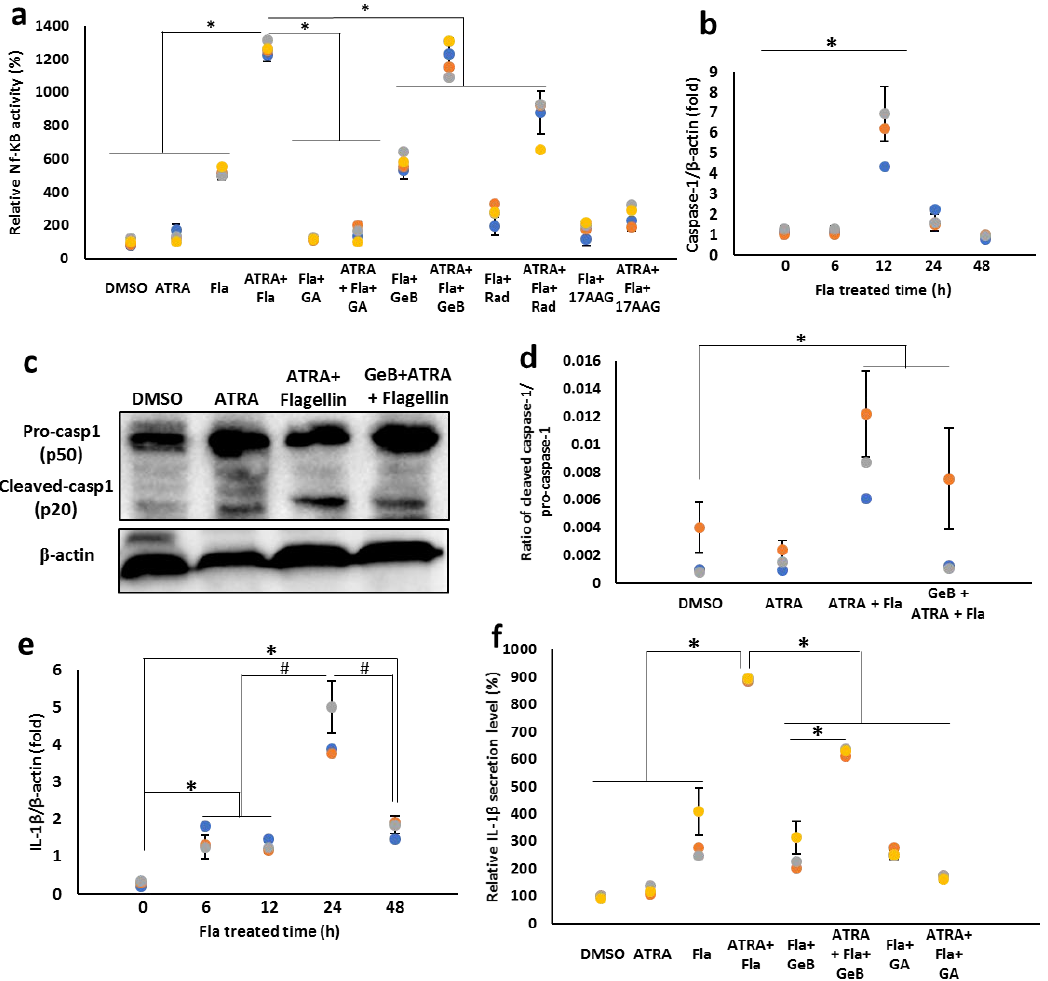
Figure 9. Exogenously administered flagellin activates caspase-1 and induces IL-1 β secretion in an Hsp90-dependent manner. ( a ) NF- κ B activity. THP-1 Xblue cells were stimulated with 1 µ M ATRA in the presence or absence of different Hsp90 inhibitors, followed by 48 h treatment with 100 ng/mL flagellin. After stimulation, a 20 µ L aliquot of the supernatant was collected and added to 180 µ L of Quanti-Blue medium for color development at 37 ◦ C. After 2 h color development, absorbance measurements were performed using an ELISA plate reader at 630 nm. Bar graphs indicate the optical density. ( b , c ) Caspase-1 mRNA and protein expression. To measure mRNA expression, THP-1 cells were treated with 1 µ M ATRA for 24 h, followed by treatment with 100 ng/mL flagellin for different time periods ( b , e ). The mRNA levels of caspase-1 ( b ) and IL-1 β ( e ) were measured by real-time qPCR. To determine protein expression, cells were stimulated with 1 µ M ATRA for 24 h, followed by treatment with 100 ng/mL flagellin for 48 h. After stimulation, caspase-1 activation and IL-1 β secretion were measured by immunoblotting ( c ) and ELISA ( f ), respectively. ( d ) The ratio of densitometry values of cleaved caspase-1 with pro-caspase-1. THP-1 cells were stimulated with 1 µ M ATRA in the presence or absence of cell surface Hsp90 inhibitor GeB, followed by 48 h treatment with 100 ng/mL flagellin. Densitometric analysis of the protein bands was performed with the ChemiDoc MP Imaging System (n = 3). ( e , f ) IL-1 β mRNA expression and secretion. * p < 0.05; # p <